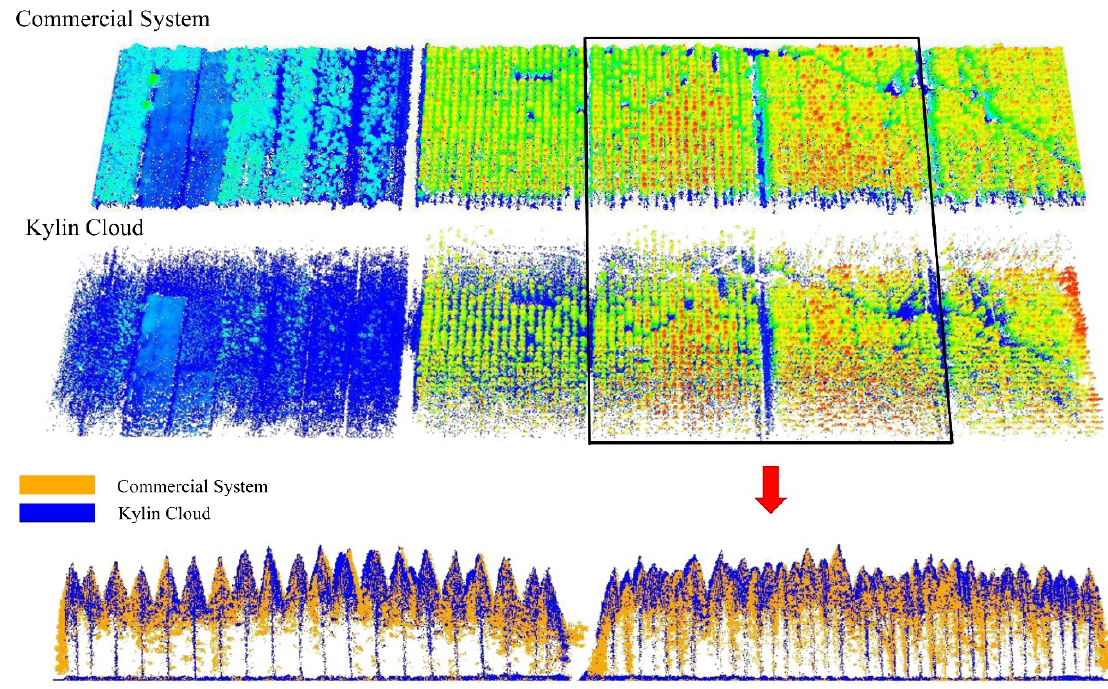
Figure 11. Visual comparison by overlaying the point clouds collected by Kylin Cloud and the ground truth data.